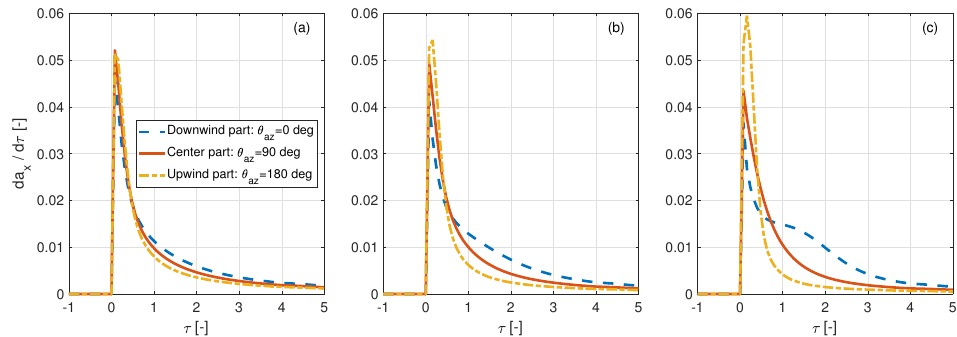
Figure 7. Time derivative of a x at different azimuth angles from CFD model when base C T = 0.6, step ∆ C T = +0.1, r/D = 0.4, ( a )